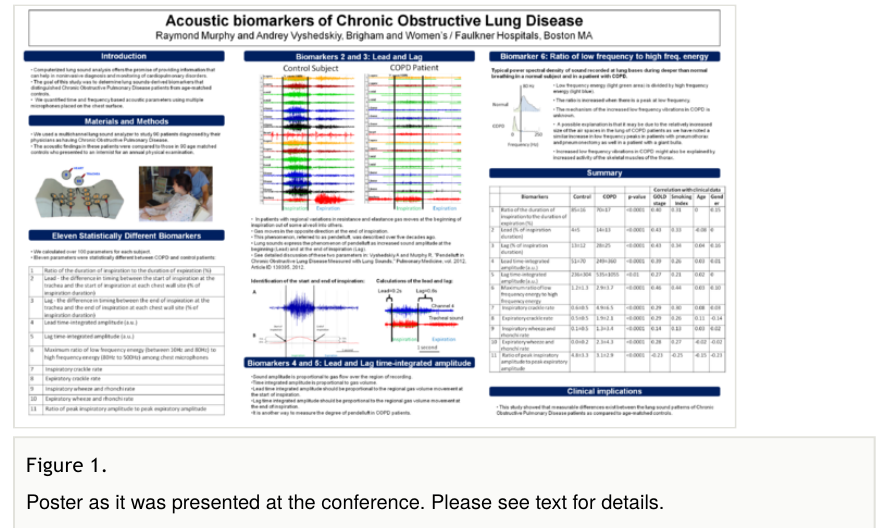
Poster as it was presented at the conference. Please see text for